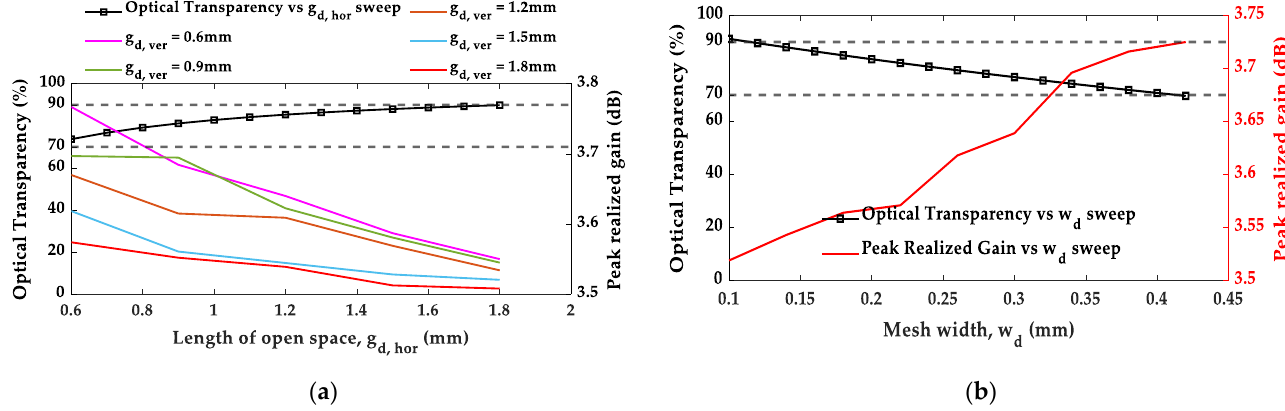
Figure 10. Effect of diamond mesh on peak realized gain: ( a ) length of the open space, 𝑔 𝑑,ℎ𝑜𝑟 , 𝑔 𝑑,𝑣𝑒𝑟𝑟 ; ( b ) mesh width, 𝑤 𝑑 .